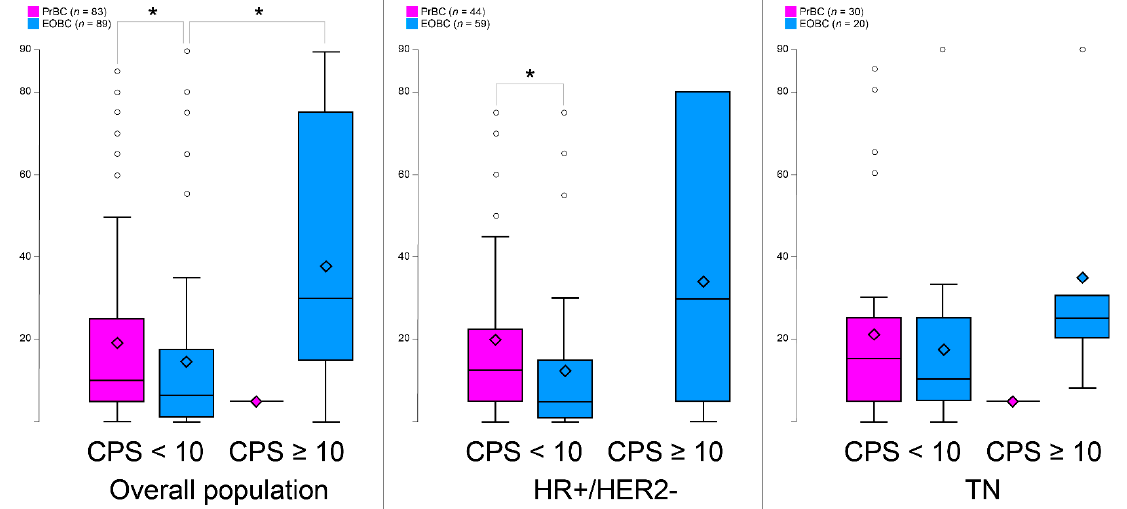
cytotoxic T-cells in the absence of the negative immune-regulatory effect of PD-L1.